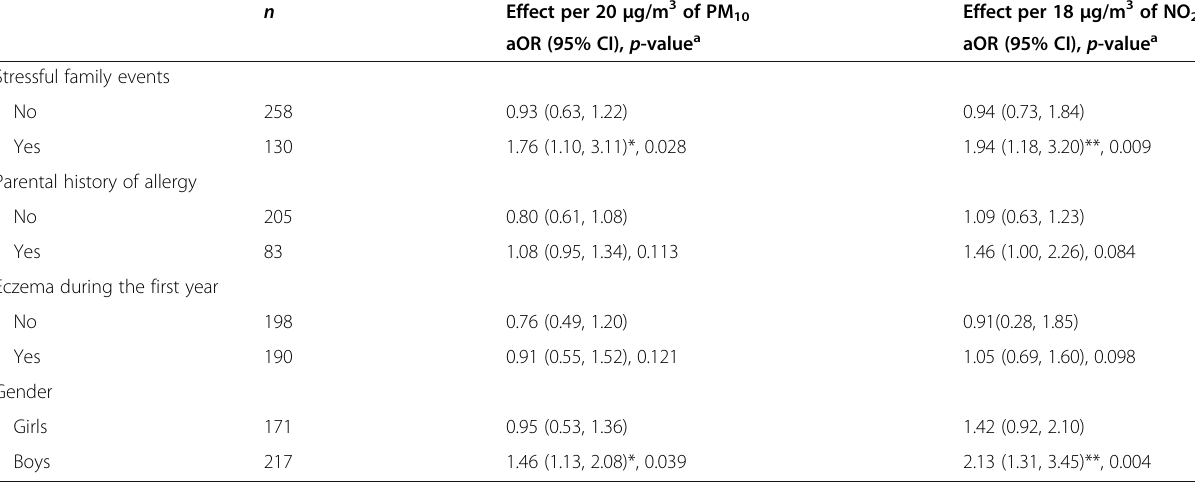
Table 6 Association (adjusted odds ratios and 95% confidence interval) between exposure and allergic rhinitis among children ( n = 388), stratified by significant covariates